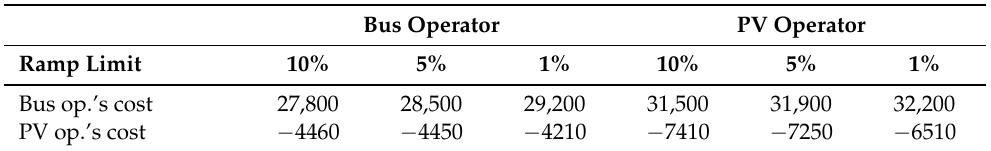
Table 3. Total cost incurred for bus operator and total revenue for the PV operator (as negative cost) for both objectives for one